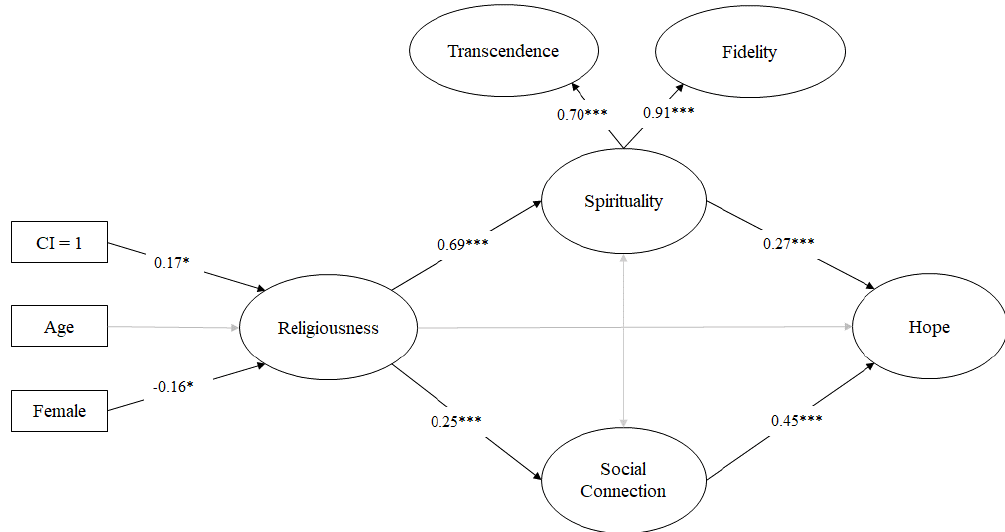
Figure 2. Final model. *** p < 0.001, * p < 0.05. Note: Regression coefficients are standardized. The covariates of age, gender, and CI enrollment were also included in the model to test their association with the latent variable of religiousness. Results suggested that boys and CI-supported youth showed higher levels of religiousness ( β = − 0.16, β = 0.17, p < 0.05, respectively). After removing all non-significant paths, the re-specified model demonstrated good fit to the data: χ 2 (266) = 350.76, p < 0.001; RMSEA = 0.02 (90% CI [0.01, 0.02]); CFI = 0.97; TLI = 0.97; SRMR = 0.04.